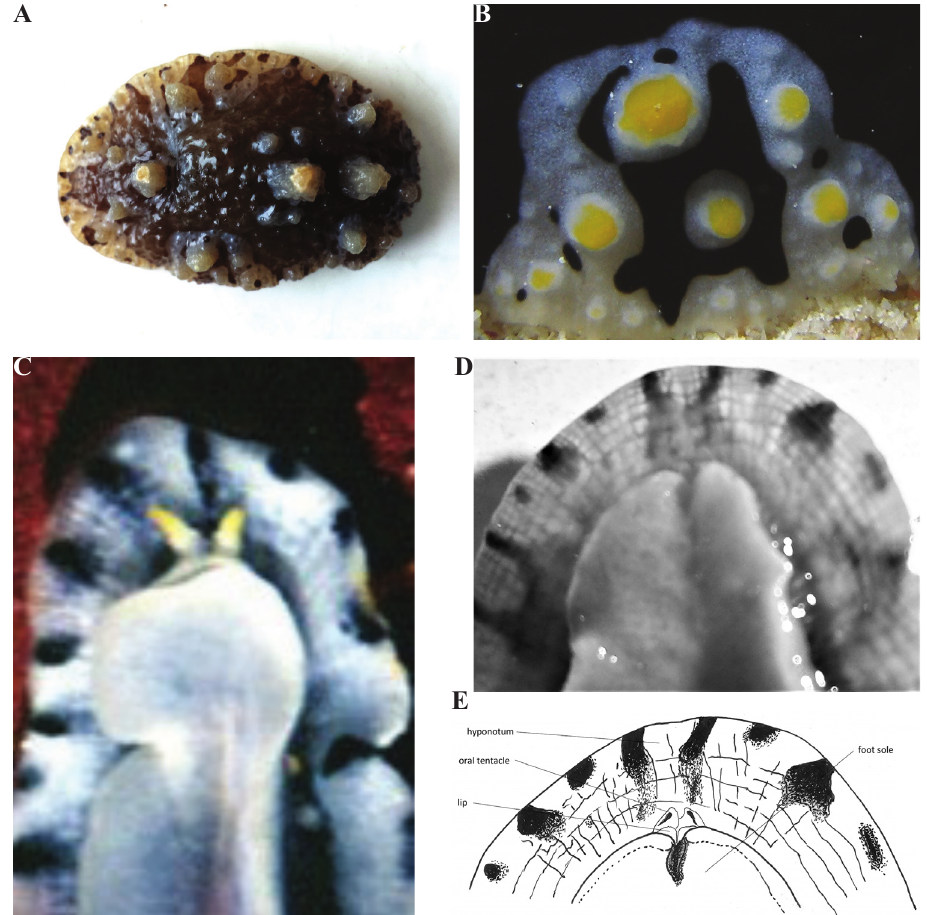
Figure 7. Phyllidia schupporum A dorsal view of preserved specimen (same orientation as living animal in Plate 9 with head to the left) B detail of lateral tubercles and margin (lower) of specimen (enlarged from photograph of the living specimen C ventral view of holotype (M. Schrödl) D, E oral tentacles, ‘lips’ and anterior foot margin of